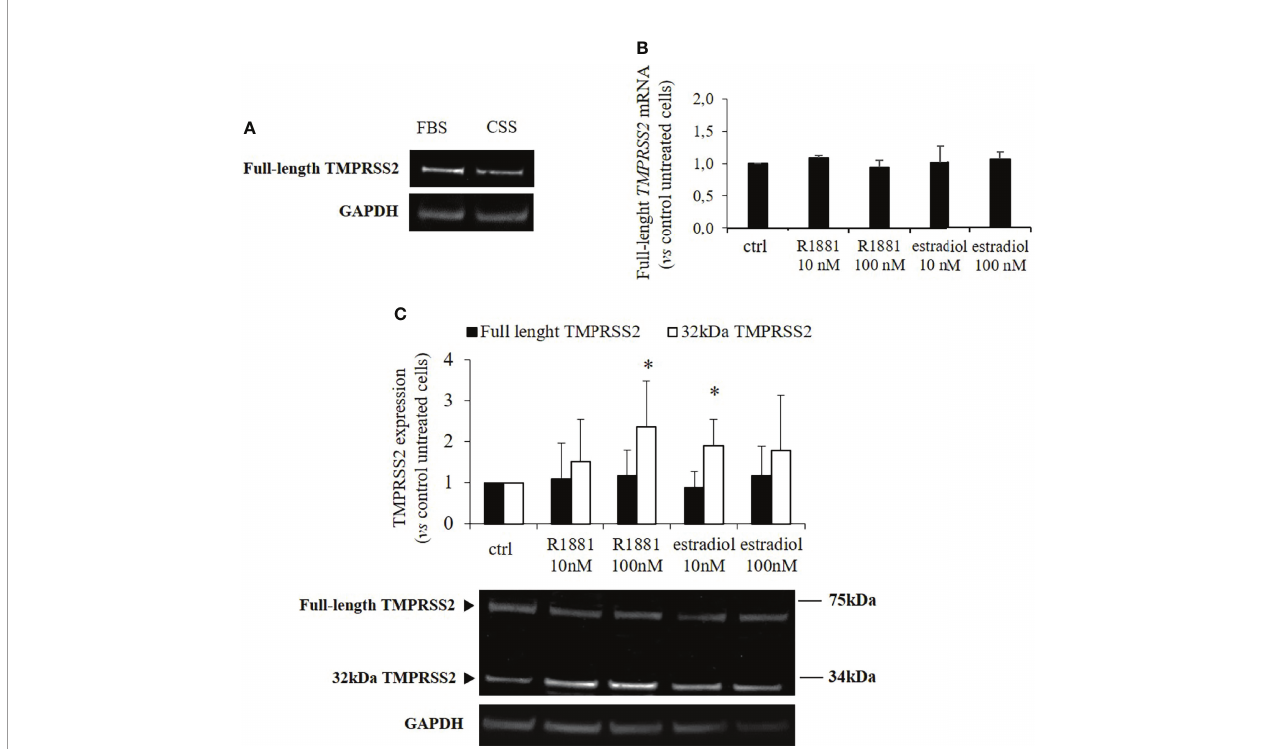
FIGURE 1 | TMPRSS2 expression in response to stimulation with R1881 and estradiol. (A) Representative Western blot showing TMPRSS2 expression in Calu-3 cells cultured in complete medium or FBS-CSS medium for one week. (B) Analysis of TMPRRS2 mRNA expression in Calu-3 cells stimulated for 30 h with the indicated concentration of R1881 and estradiol in FBS-CSS medium. (C) Representative Western blot and densitometrical analysis of bands corresponding to the full-length form of TMPRSS2 and the 32kDa cleaved fragment containing the protease domain. Proteins were extracted from Calu-3 cells treated with the indicated concentration of R1881 and estradiol in FBS-CSS medium for 30 h. GAPDH was used as housekeeping gene for normalization. Experiments were performed in triplicate and results are expressed as mean ± SD. * = p < 0.05 vs control untreated